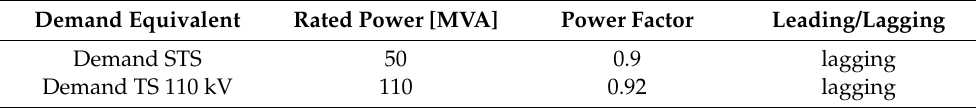
Table A7. Electrical parameters for the demand equivalents used in the sample power